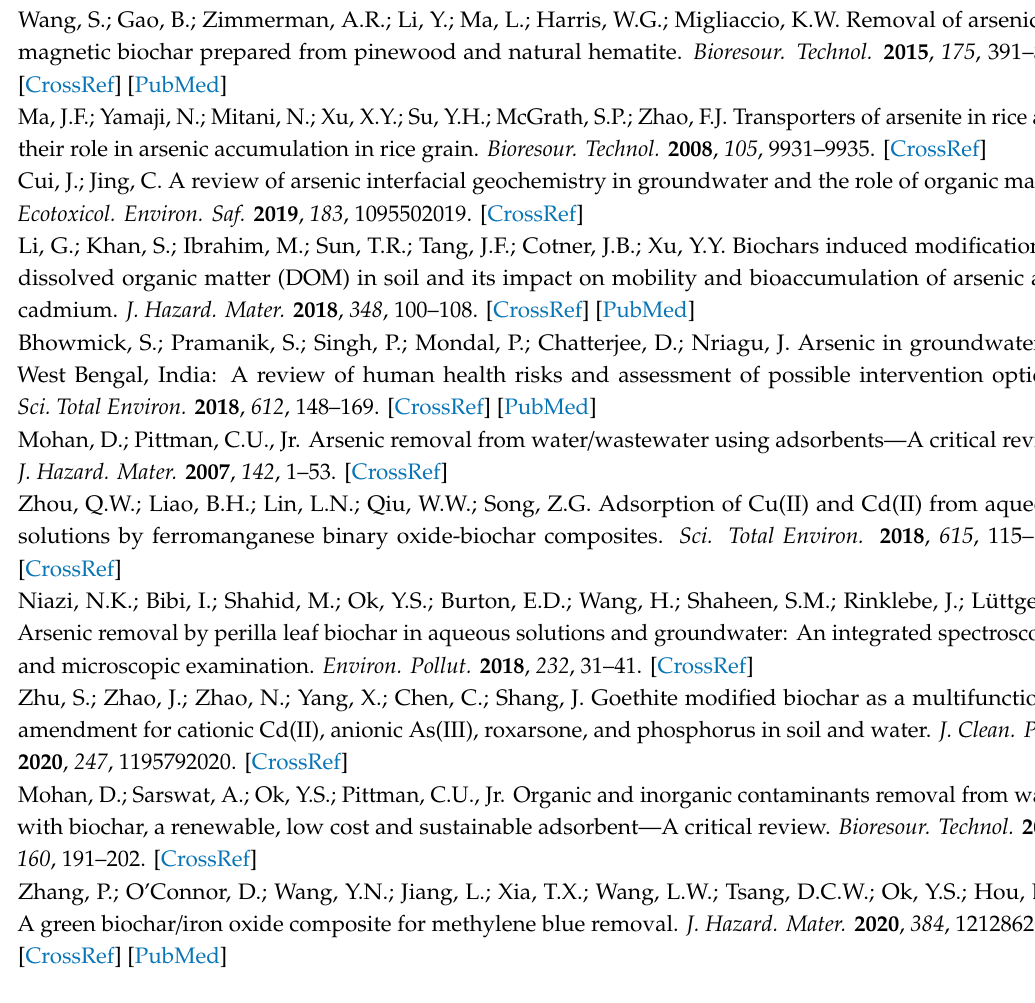
Figure S1: SEM images of (a) BC and (b) MBC. Figure S2: N 2 adsorption / desorption isotherms of (a) BC and (b) MBC, respectively. Inset: the corresponding pore size distribution of the aforementioned two adsorbents. Figure S3. X-ray di ff raction pattern of MnO 2 , CeO 2 , BC and MBC. Figure S4. Adsorption isotherm under di ff erent temperatures. Figure S5. Thermodynamic analysis of As(V) adsorption by MBC. Figure S6. Adsorption isotherm at di ff erent initial pH values. Figure S7. E ff ect of ionic strength on the adsorption of As(V) by MBC. Figure S8. E ff ect of MBC dosage on As(V) adsorption. Table S1: Kinetics parameters for As(V) adsorption onto two di ff erent adsorbents. Table S2. Parameters for As(V) adsorption by MBC. Table S3. Equilibrium adsorption isotherm fitting parameters of As(V) onto